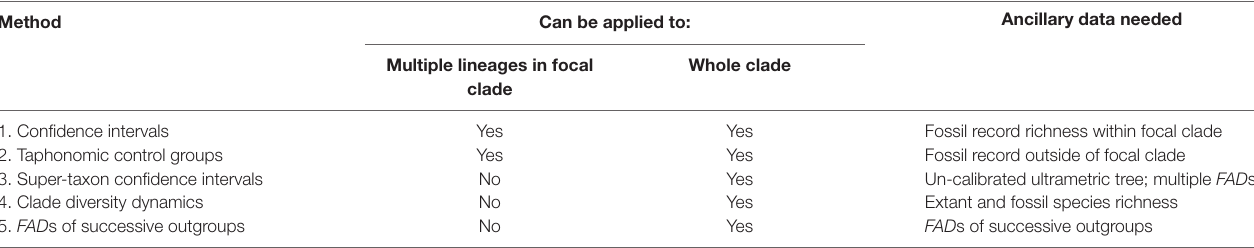
TABLE 1 | Methods that use fossil data to place soft maxima on times of origin of first fossilizable apomorphies, that is, to estimate the size of ΔT Gap ( Figure 1A ). See text for citations. Method Can be applied